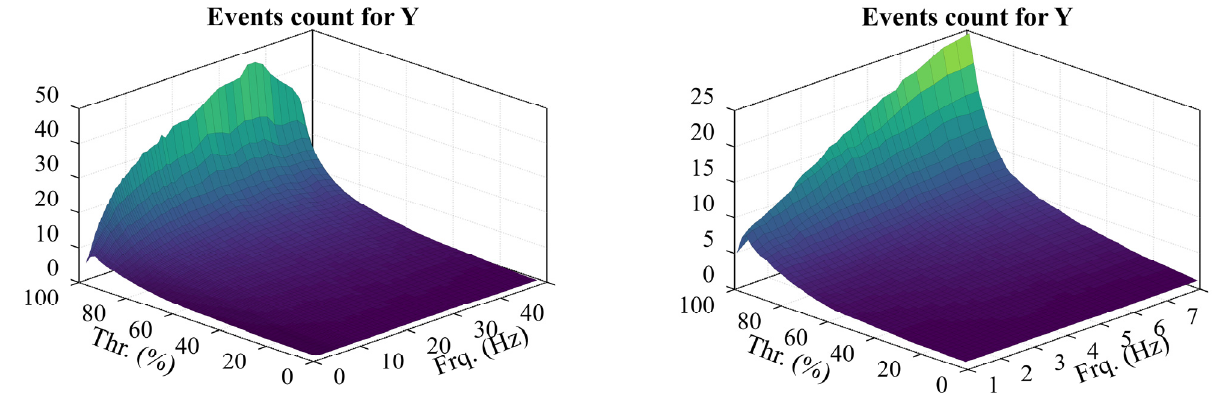
Figure 22. Analyzing the overall number of impact events concerning the intended threshold levels and frequency ranges along the Z-axis.